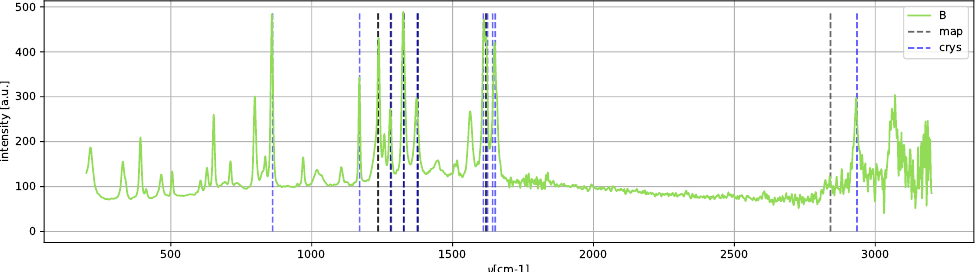
Figure 14. Spectrum B , assigned to crystallized form